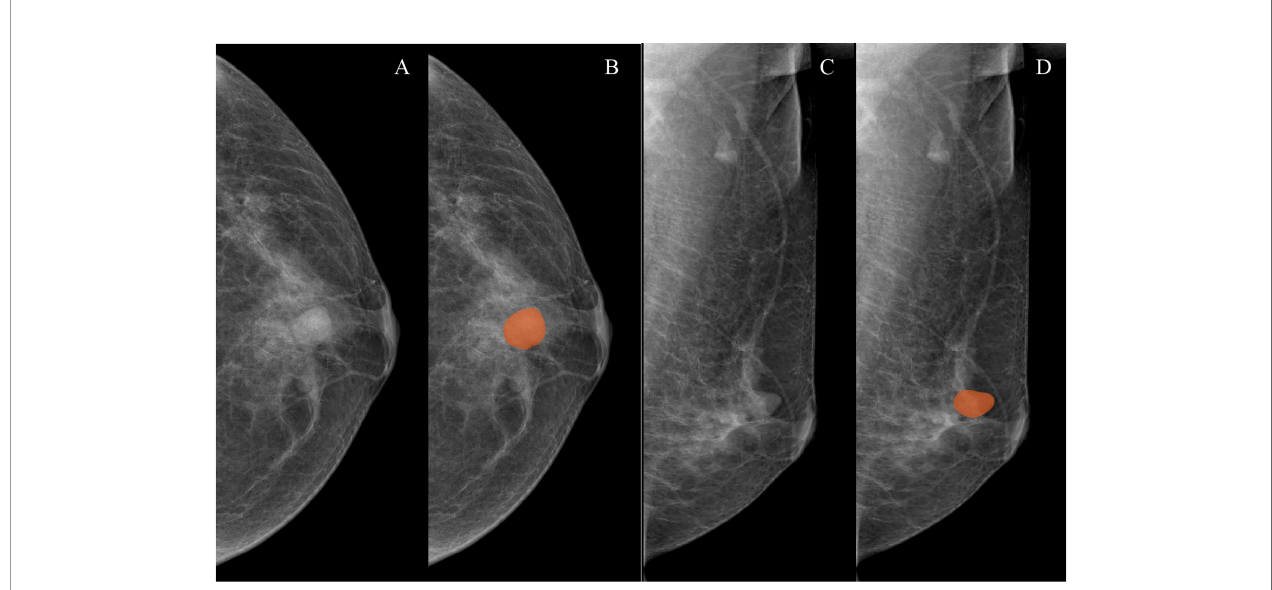
FIGURE 1 | Examples of mammographic masses masking on digital mammography images. (A, C) Craniocaudal (CC) position images and mediolateral oblique position (MLO) images, respectively. (B, D) Manually drawn areas of mammographic masses masking on CC and MLO images,